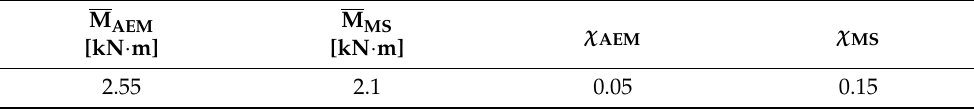
Table 4. Characteristics of external excitations of